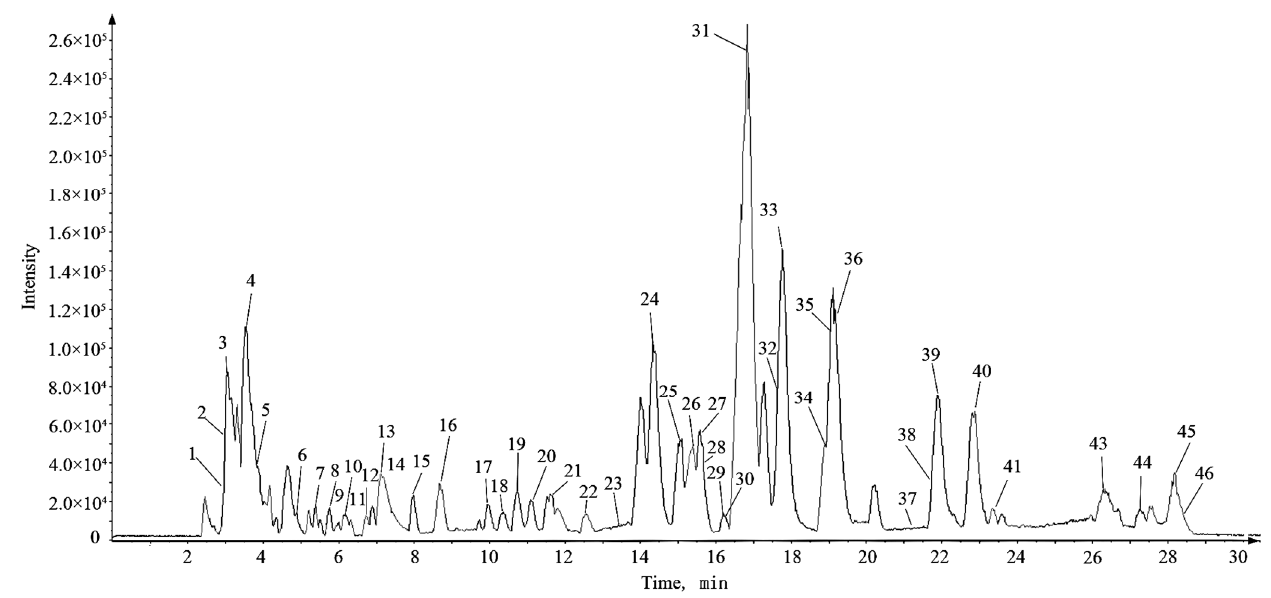
Figure 1. The base peak chromatogram (BPC) of Lysimachiae Herba from Sichuan Bazhong in negative ion mode.